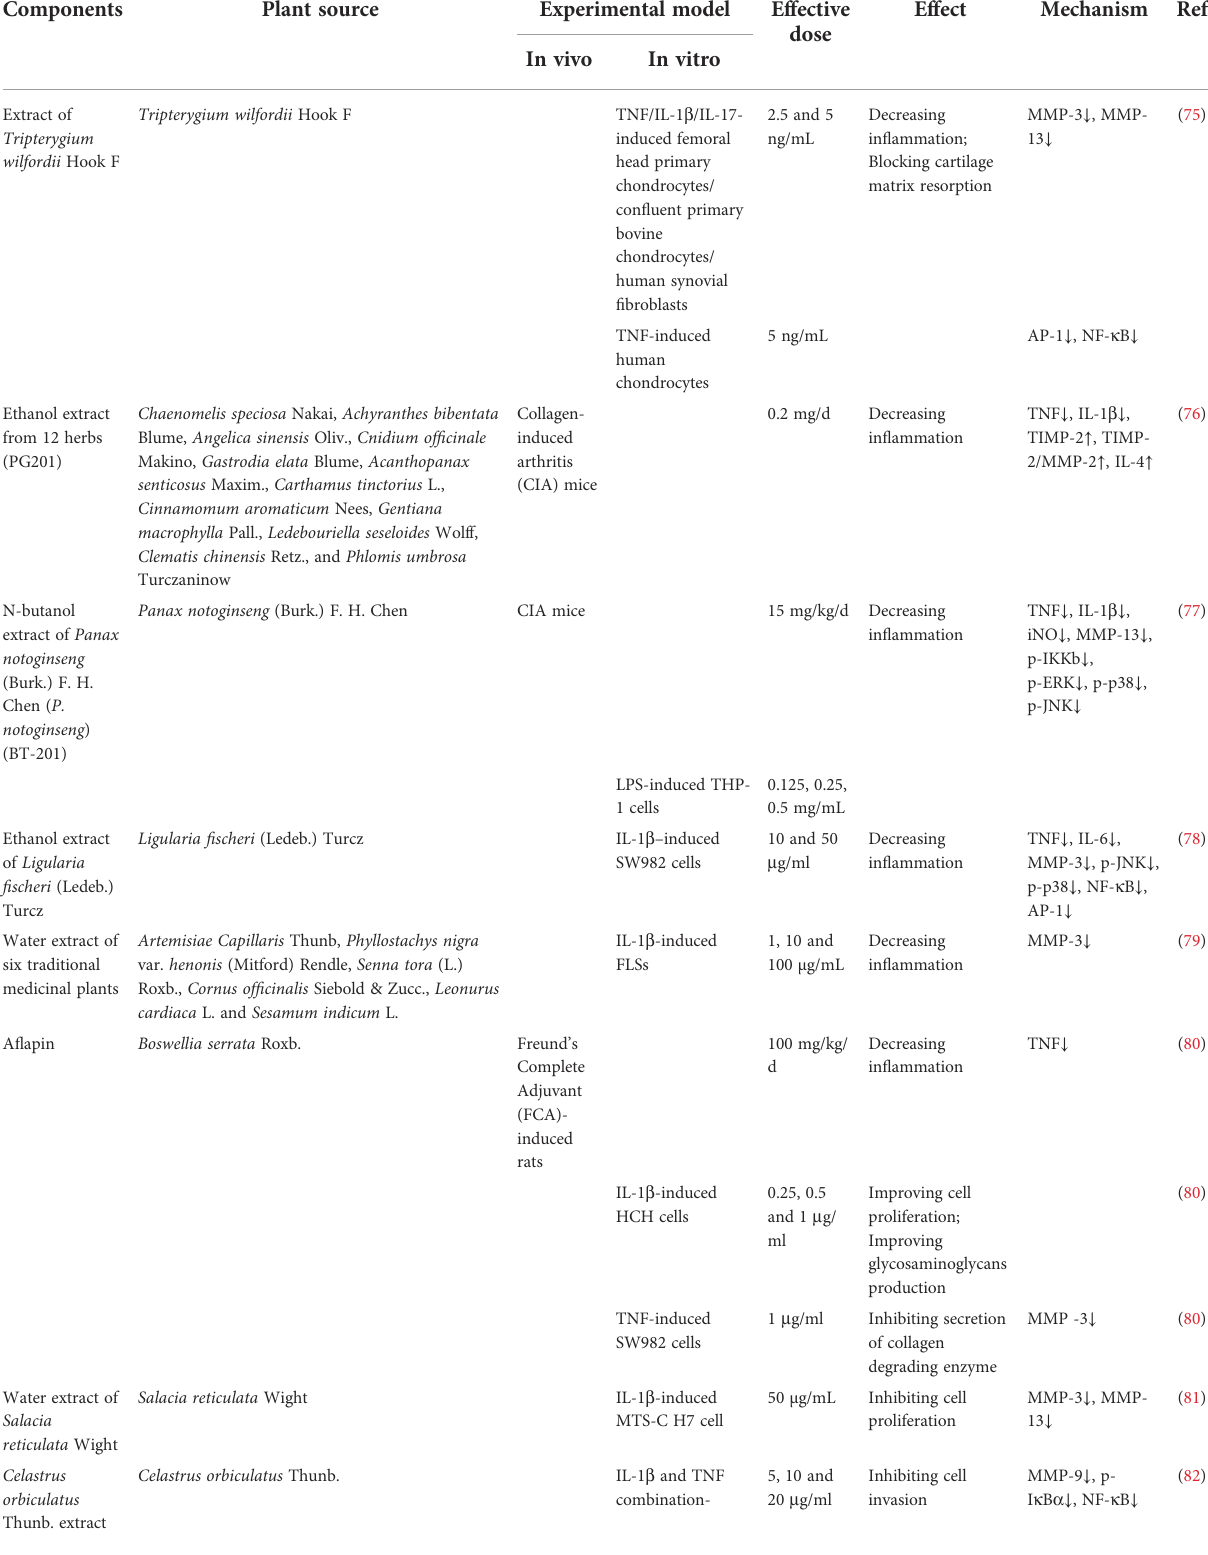
TABLE 2 Plant extracts that can treat rheumatoid arthritis by regulating